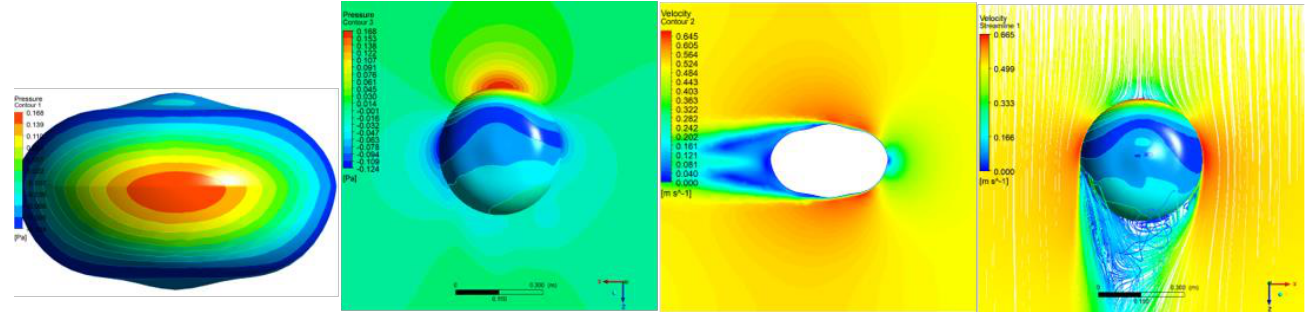
Figure 6. CFD simulations of the shell without fins, due to the complete circumferential symmetry of the disc shape, pressure, and velocity around the shell do not change with the rotation.